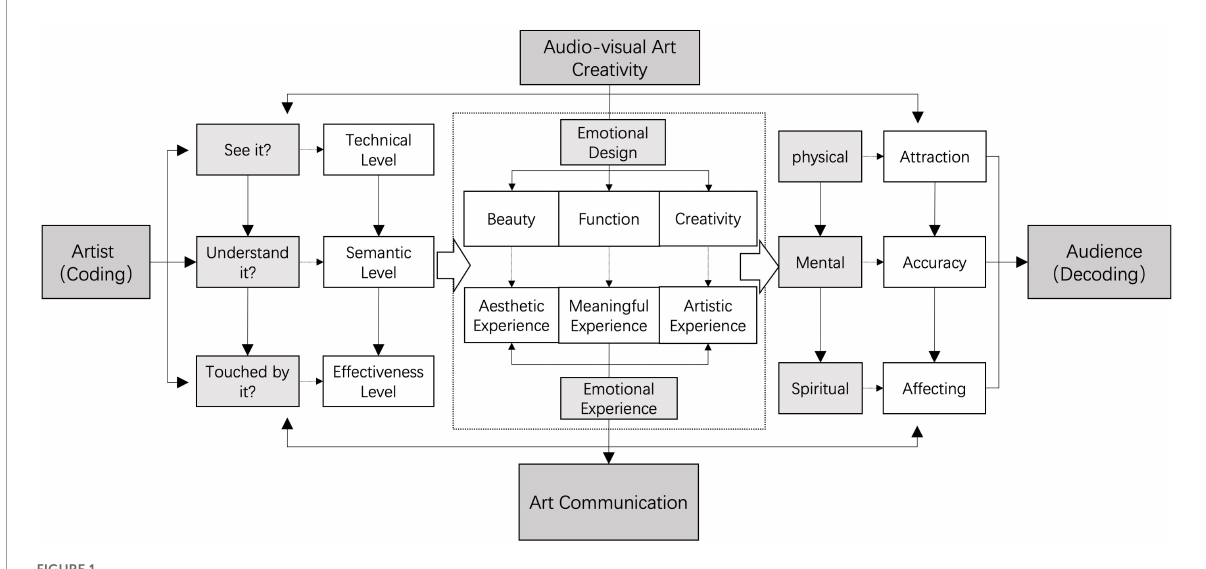
FIGURE1 The emotional communication mode of audio-visual